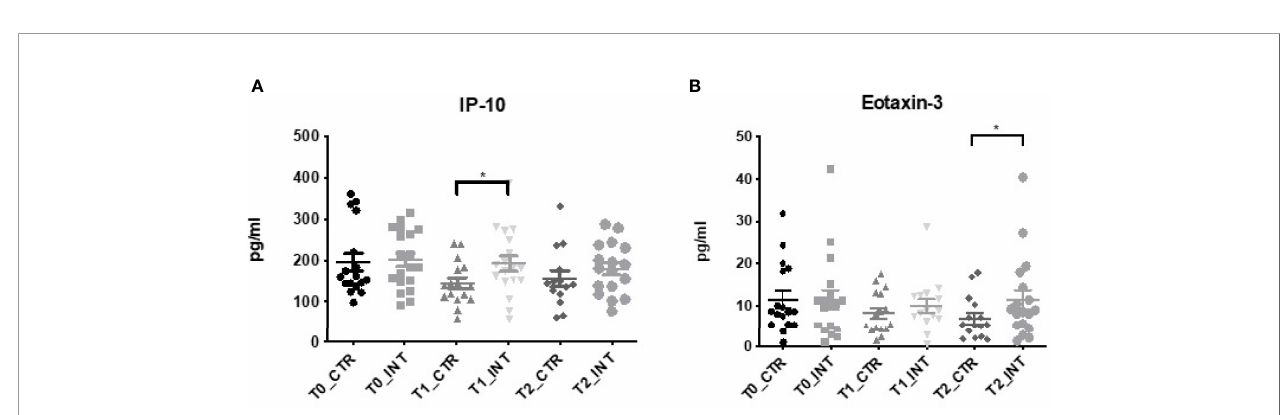
FIGURE 2 | Exercise intervention increases IP-10 and Eotaxin – 3 expression. Data at immediately post 12-week intervention (Time 1; T1) and at 3-month follow-up (Time 2; T2) was analyzed using linear regression models, adjusting for baseline values (T0). A signi fi cant increase in serum (A) IP-10 expression was observed at T1 between control and intervention cohorts while a signi fi cant increase in (B) Eotaxin-3 was observed at T2 (*p ≤